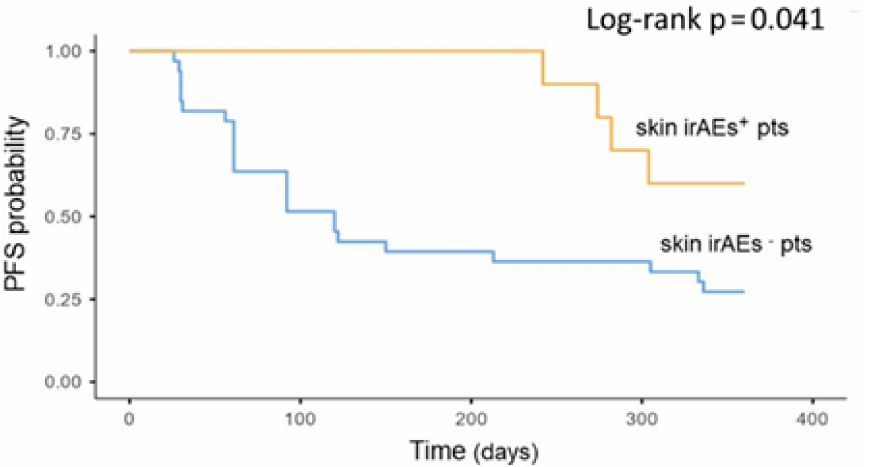
Figure 2. Association between skin toxicity during treatment and oncologic outcomes. Kaplan–Meier plots of progression-free survival. irAEs = immune-related adverse events; PFS = progression-free survival; pts = patients.